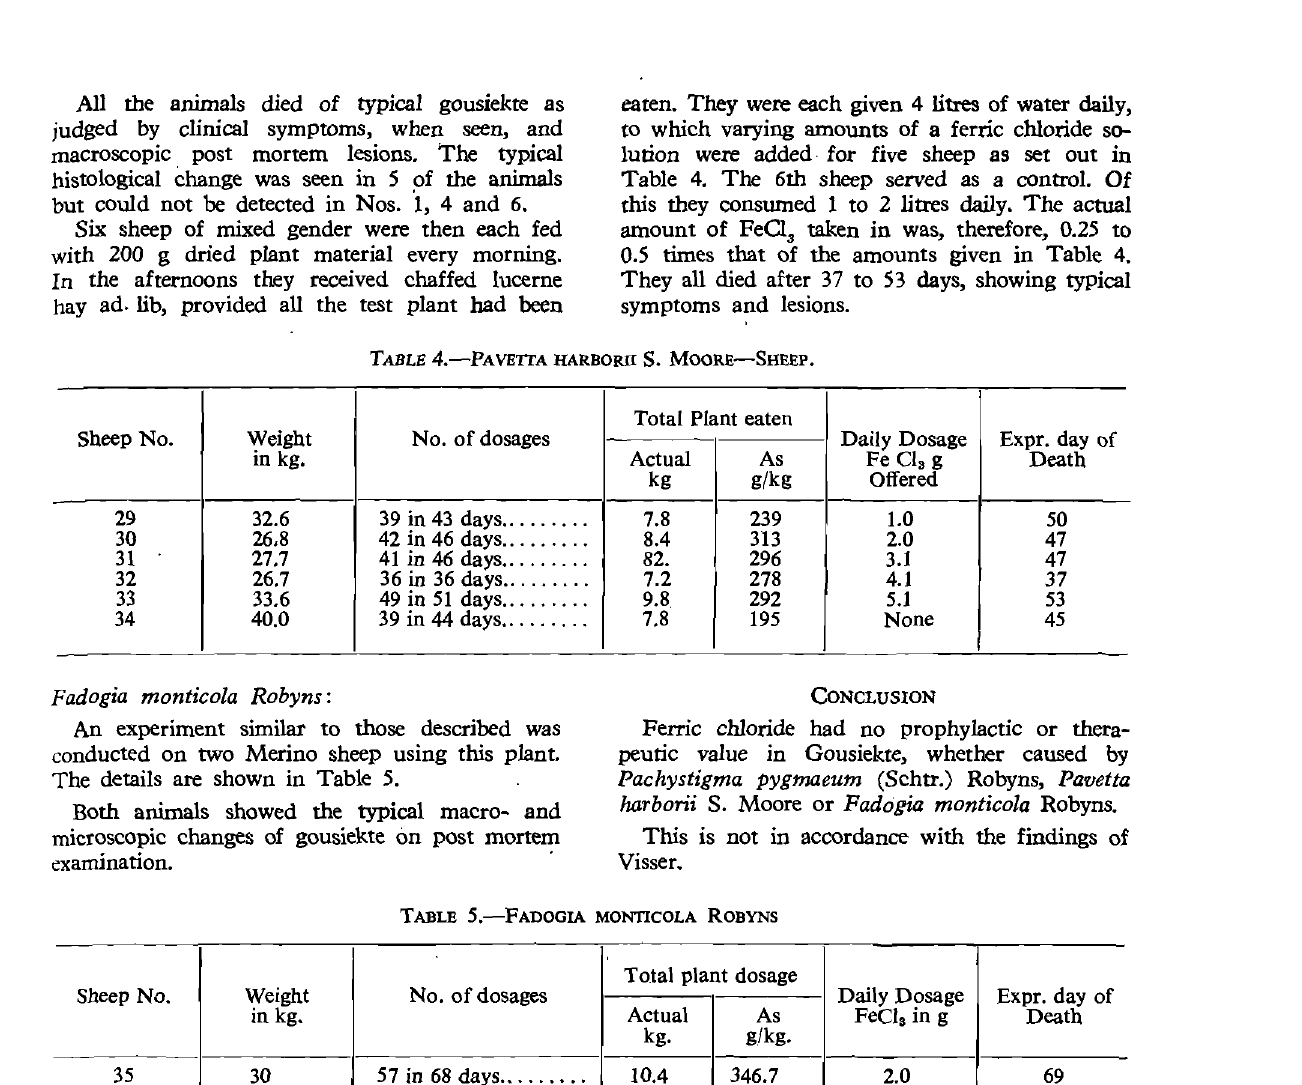
TABLE 5.-FADOGIA MONTICOLA